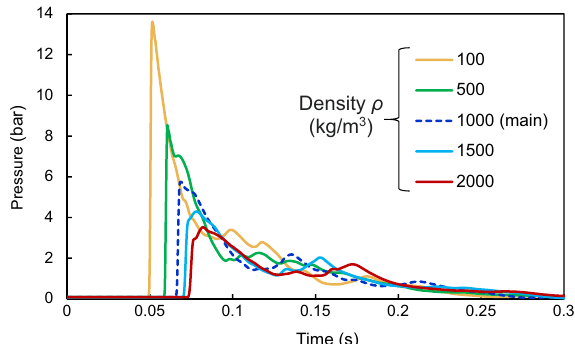
Figure 12. Pressure–time diagrams of model W-2000-20-0.15@20 as a function of the density ρ